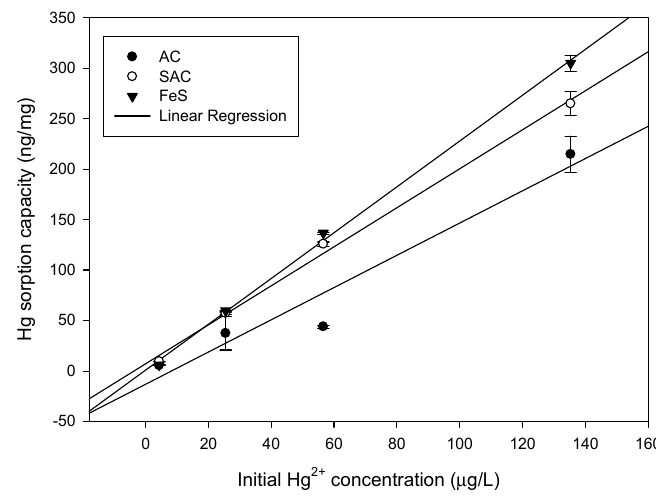
Figure 3. Hg sorption at different Hg 2+ concentrations.